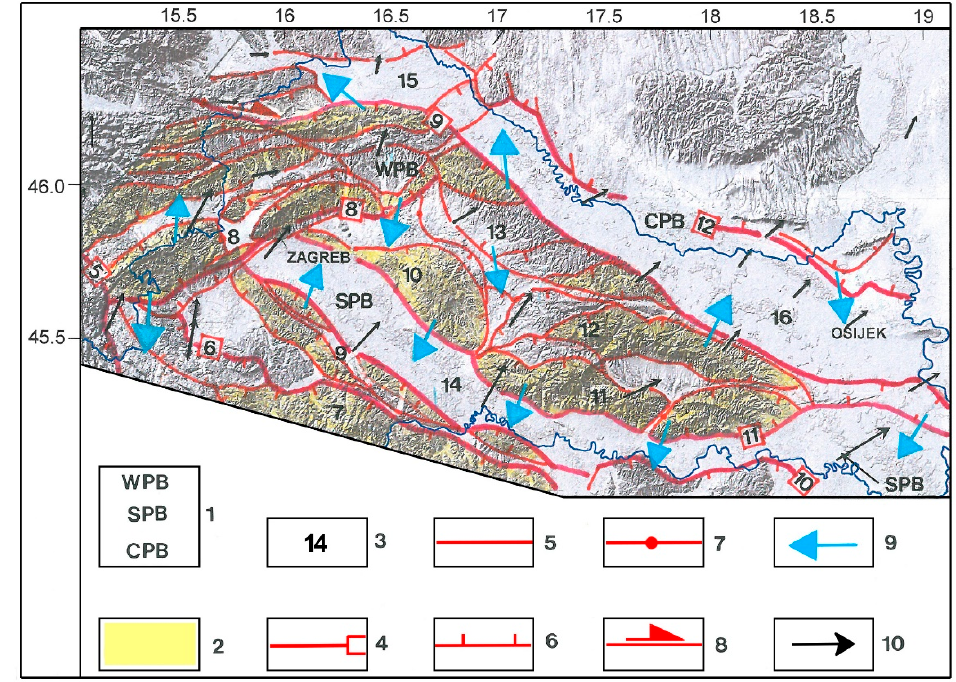
Figure 12. Recent geological structural setting and tectonic activity in the area of the Pannonian Basin. Legend: 1—Regional geological structural units: Pannonian Basin: Western (WPB), Southern (SPB), and Central (CPB); 2—the most prominent structural units within the regional geological structural units along whose wings are reverse faults of opposite vergence: Petrova gora –Kozara (7), Žumberak–Medvednica (8), Vukomeri č ke gorice–Šamarica (9), Moslava č ka gora Gora (10), Psunj–Dilj gora (11), Papuk (12), and Bilogora (13); 3—large basins: Sava (14), Mura (15), and Drava (16); 4—major faults adjacent to regional structural units and the Sava and Drava Basins: the southern boundary fault of the Pannonian Basin, Zagreb fault (8), Periadriatic fault and continuation of the Drava fault (9), Sava fault (10), Zagreb–Vinkovci fault (11), and Barcs–Baranja fault (12); 5—other important faults; 6—reverse faults; 7—faults of indeterminate character; 8—direction of horizontal movement along the fault; 9—direction of movement of parts of structures along the surface according to geological data; 10—direction of annual velocity at geodetic points in mm/yr.